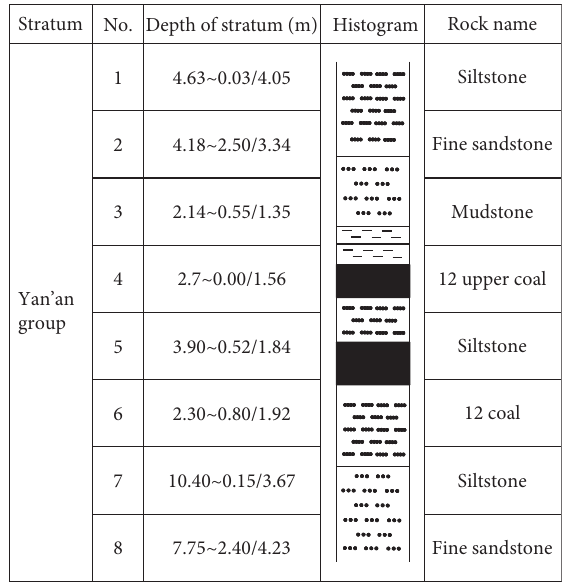
Stratum No. Depth of stratum (m) Histogram